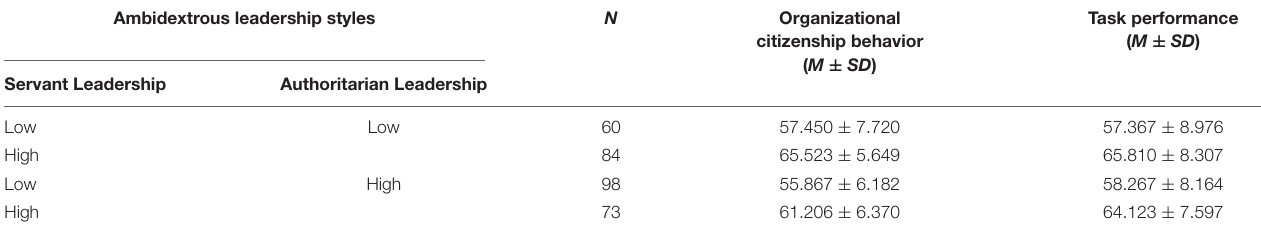
Ambidextrous leadership